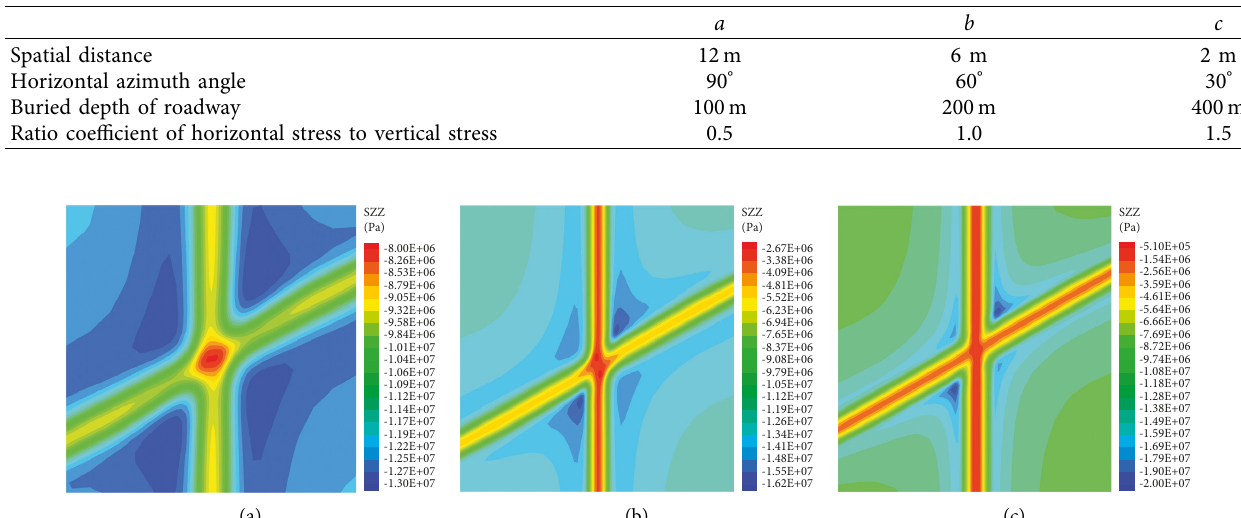
Figure 3: Disturbance influence of distance between roadways on surrounding rock vertical stress of staggered roadway. (a) Distance between roadways 12m,(b) distance between roadways 6m, and (c) distance between roadways 2m.